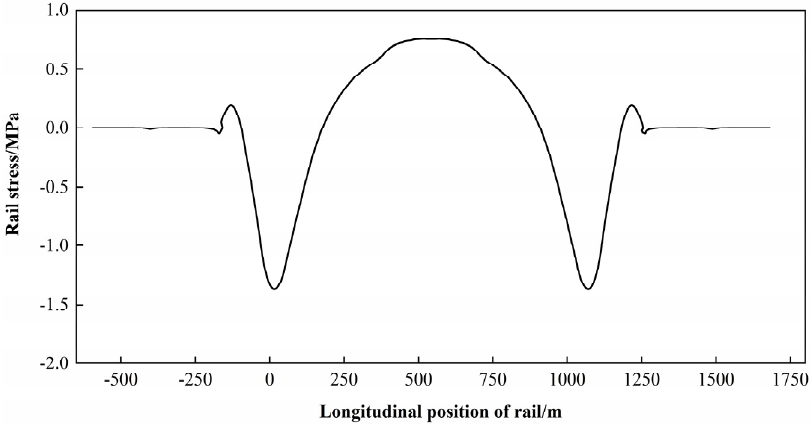
Figure 6. Rail initial stress. Table 2. Comparison of main cable Internal force and sling Internal force results.